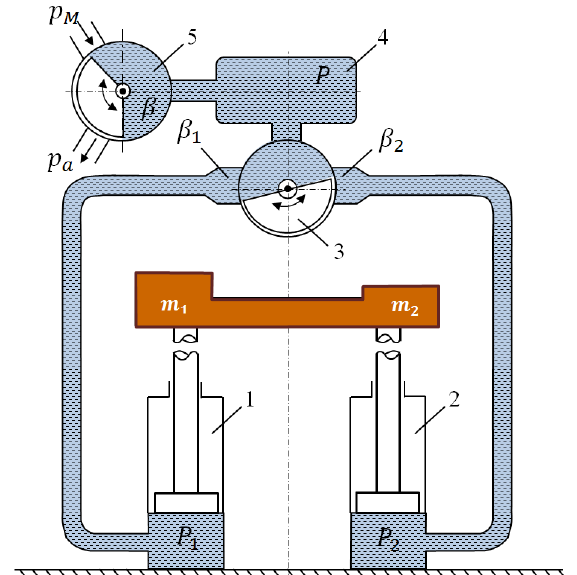
Figure 1. The model of the manipulator with two hydraulic actuators: p M —actuator supply pressure; p a —atmospheric pressure; P 1 , P 2 , P —pressure in the cavities 1, 2, 4, respectively; β , β 1 , β 2 —relative opening areas of the respective